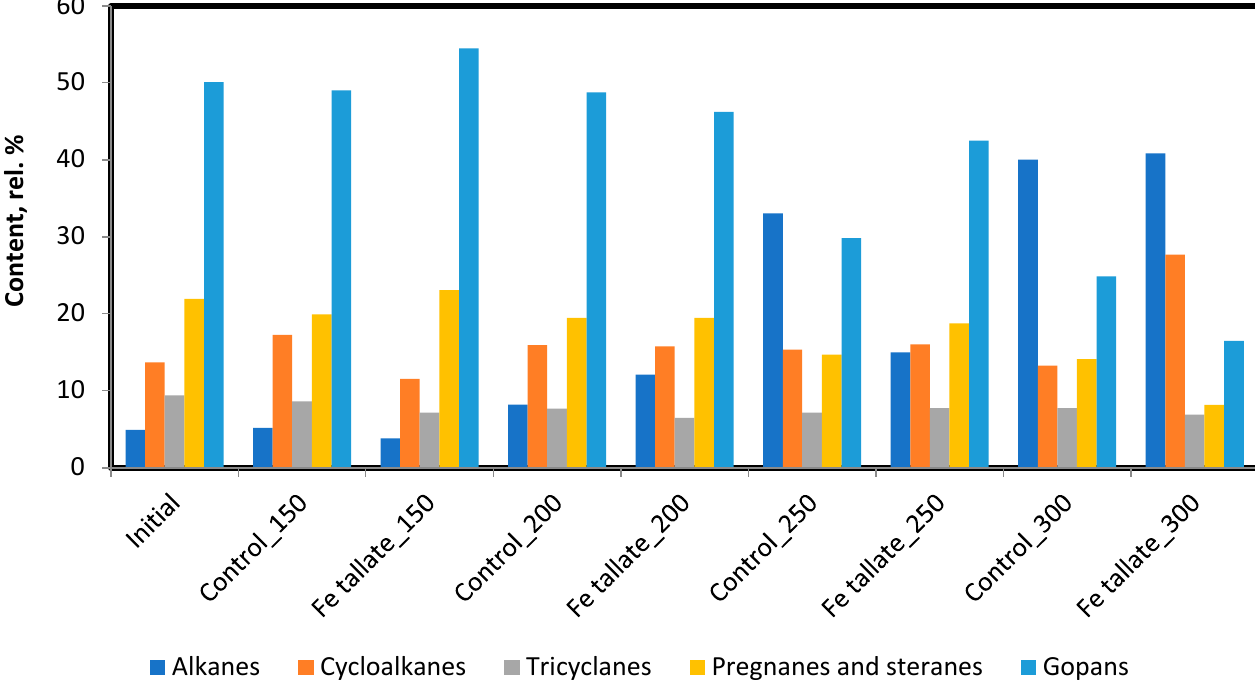
Figure 11. Relative content of identified compounds in saturated fraction.